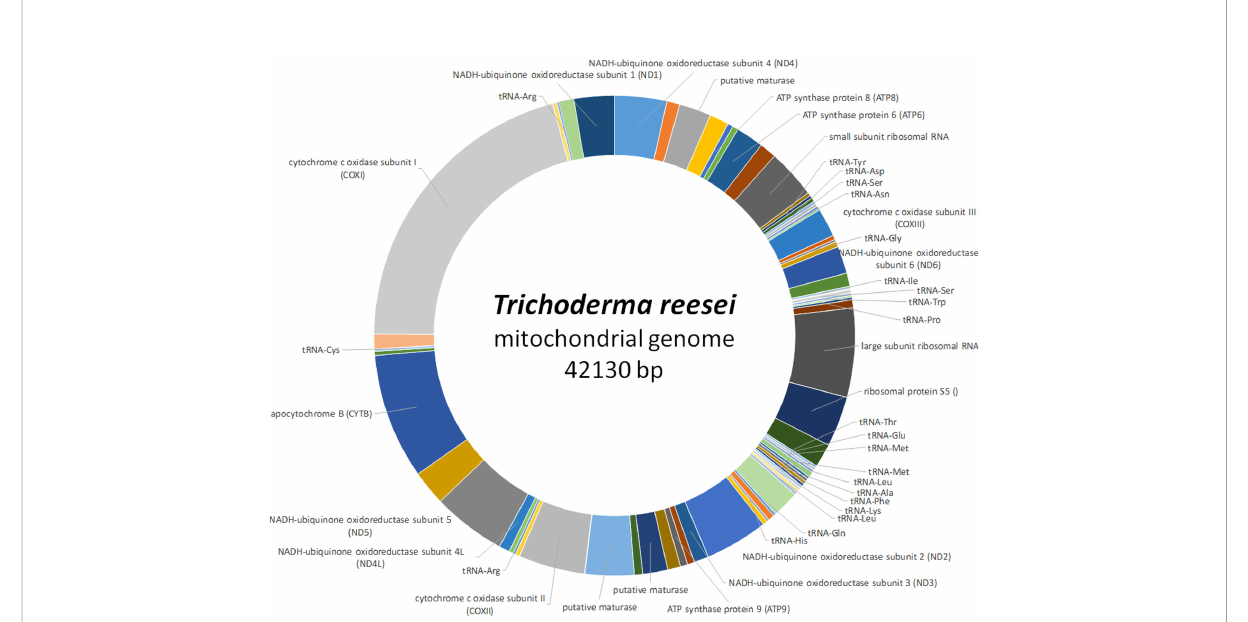
FIGURE 3 Schematic representation of the mitochondrial genome of T. reesei . The complete mitochondrial genome of T. reesei (GenBank accession number NC_003388) is shown along with encoded genes (Chambergo et al., 2002). Areas without label represent intergenic